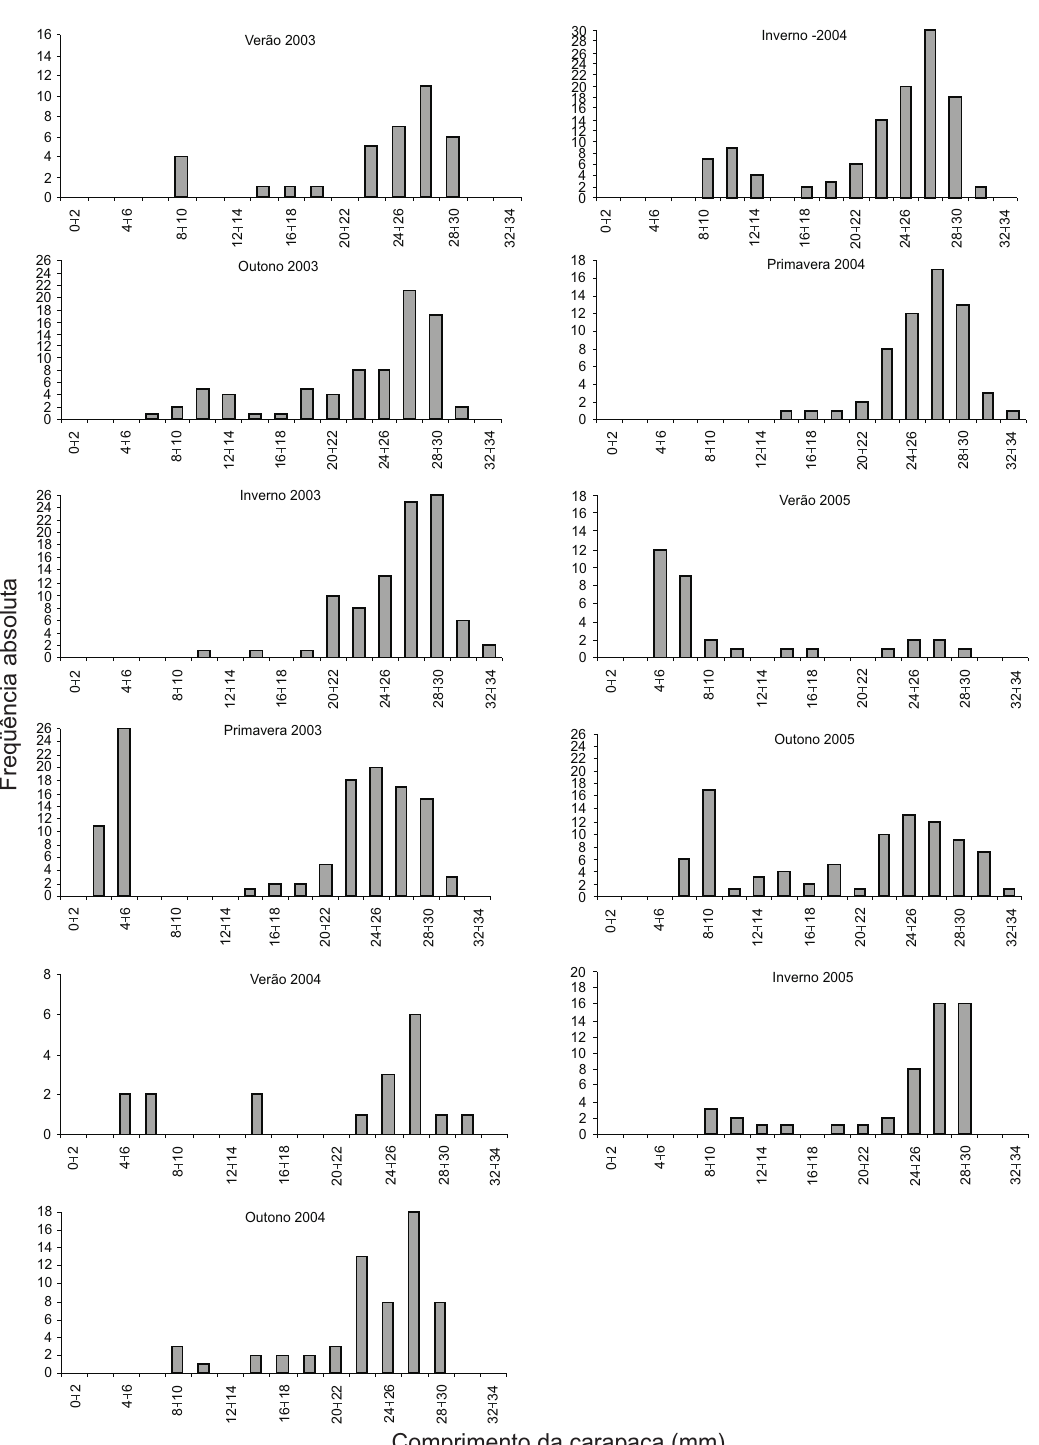
Figura 1. Distribuição das freqüências absolutas sazonais do comprimento da carapaça (mm) de P. defossus , coletados no período de janeiro de 2003 a agosto de